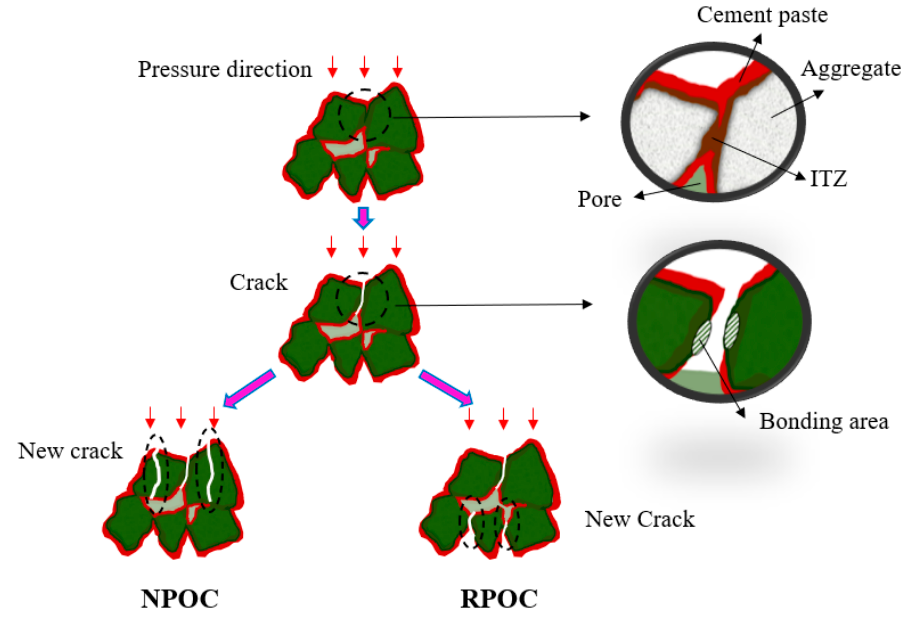
Figure 14. Conceptual diagram of porous concrete compression damage.